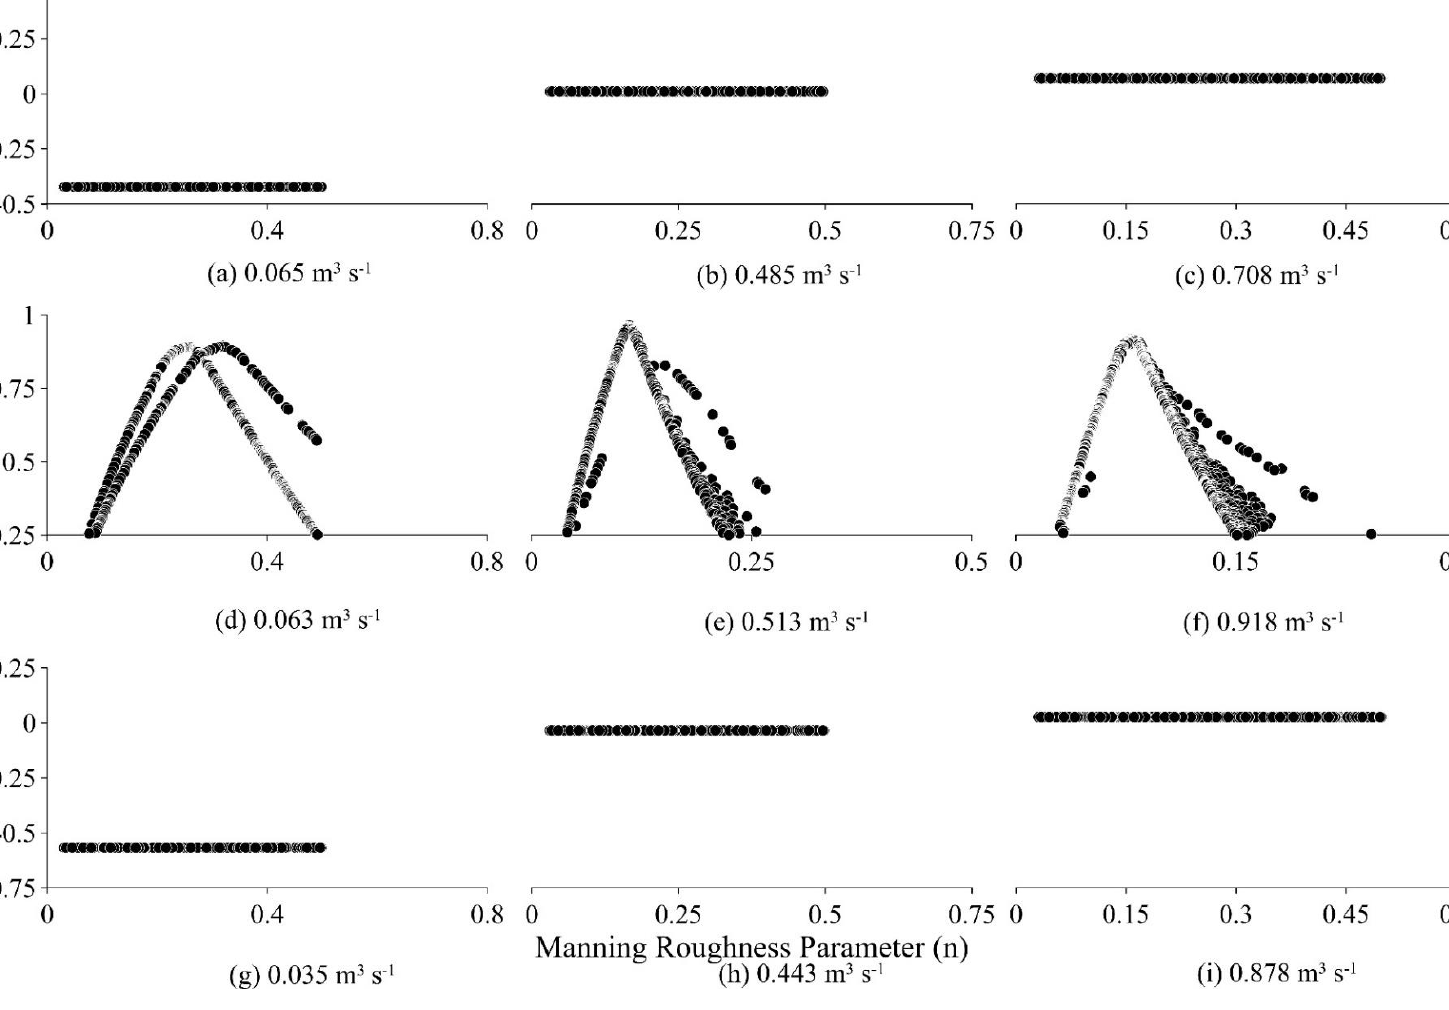
Figure 5. GLUE likelihood curves in Experiment 2: Cascade ( a – c ), Plane-bed ( d – f ), and Step-pool ( g – i ).